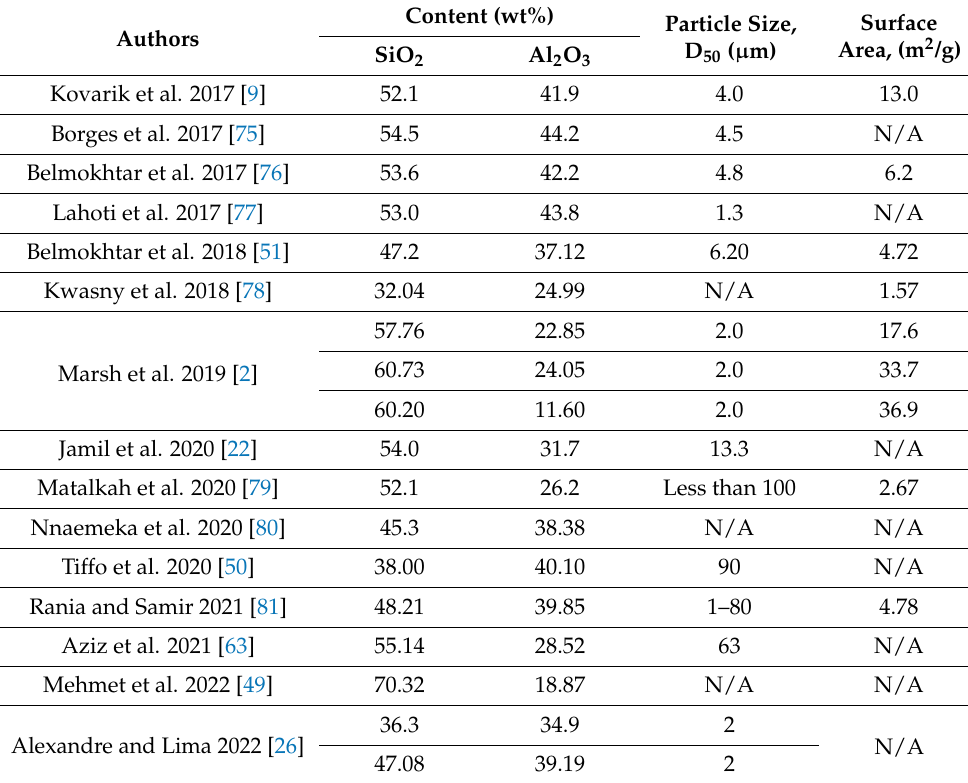
Table 3. Si and Al content of kaolin for geopolymer